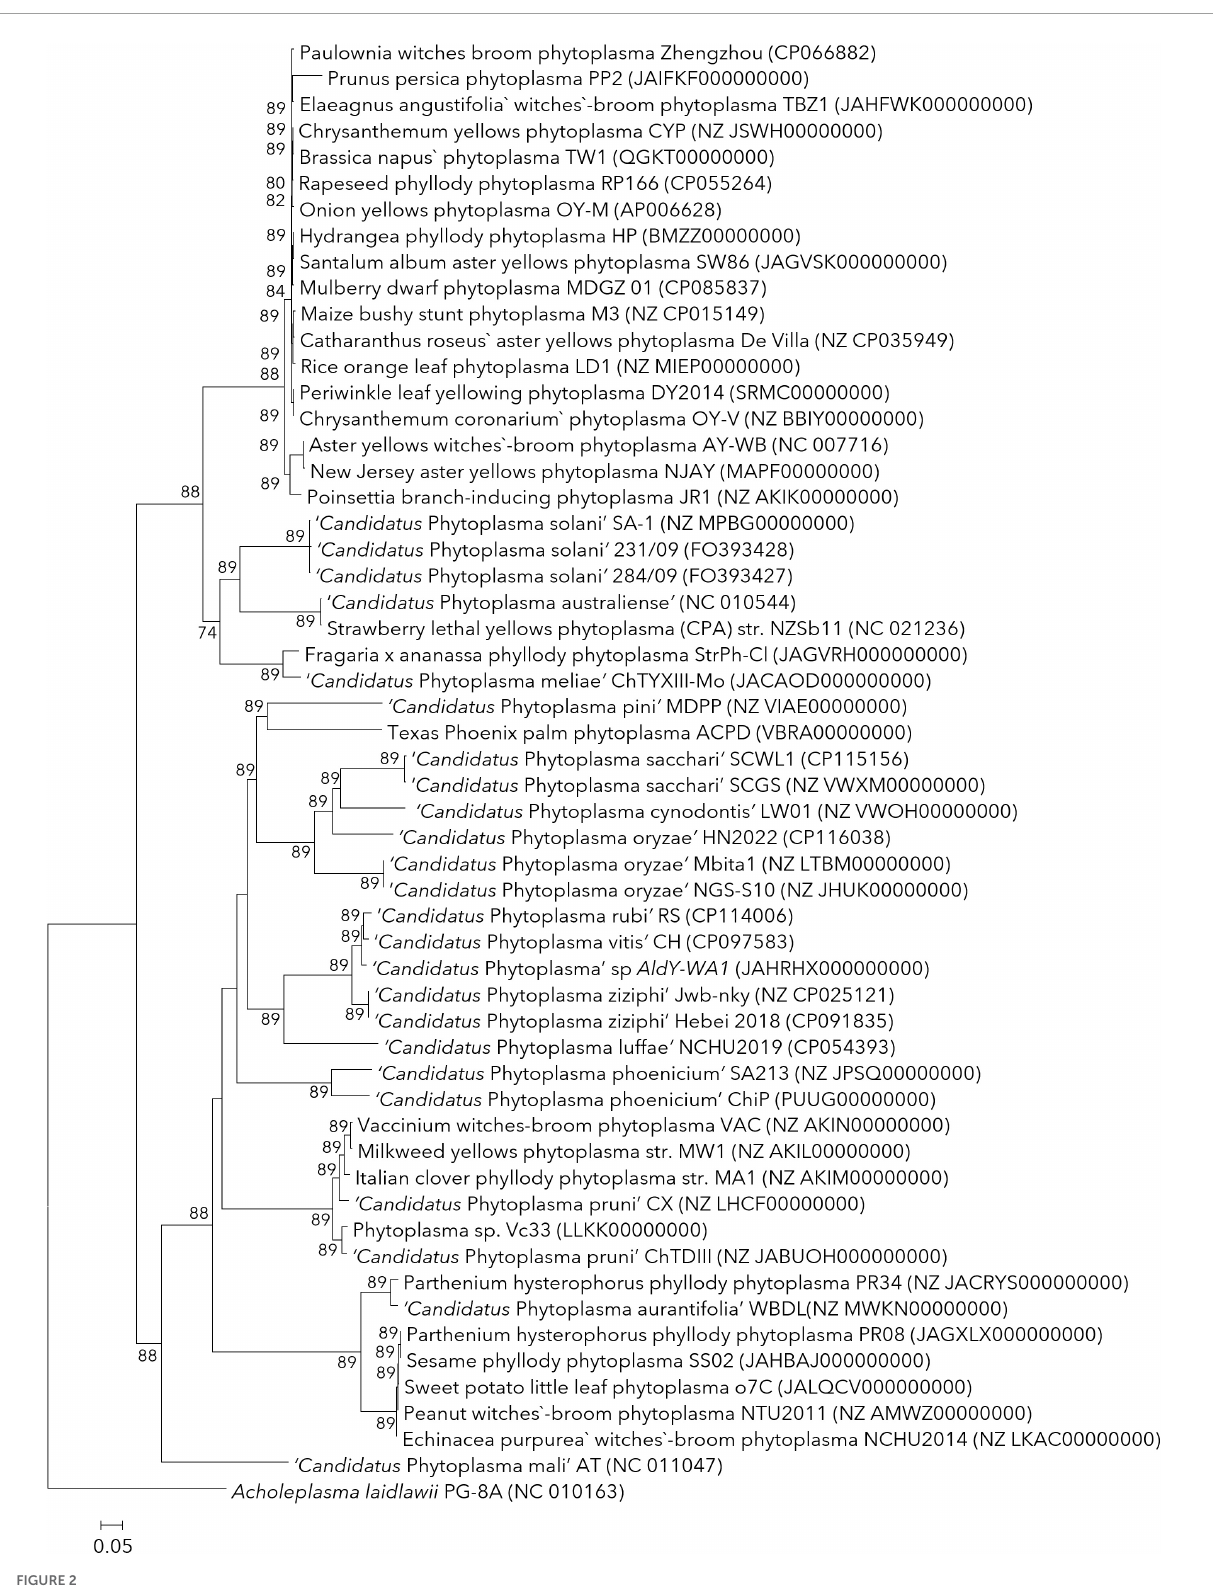
FIGURE2 The pan-genome phylogenetic tree of phytoplasma based on orthologous gene sequences computed using the UBCG tool (Na et al., 2018). The length of UBCG concatenated alignment was 86,460 containing 89 marker genes identified using HMMER (Potter et al., 2018) and predicted using Prodigal (Hyatt et al., 2010) search. Figures at branch points are bootstrap values ( > 50). The genome of Acholeplasma laidlawii PG-8A (NC_010163) was used as an outgroup. Bar indicates the number of substitutions per